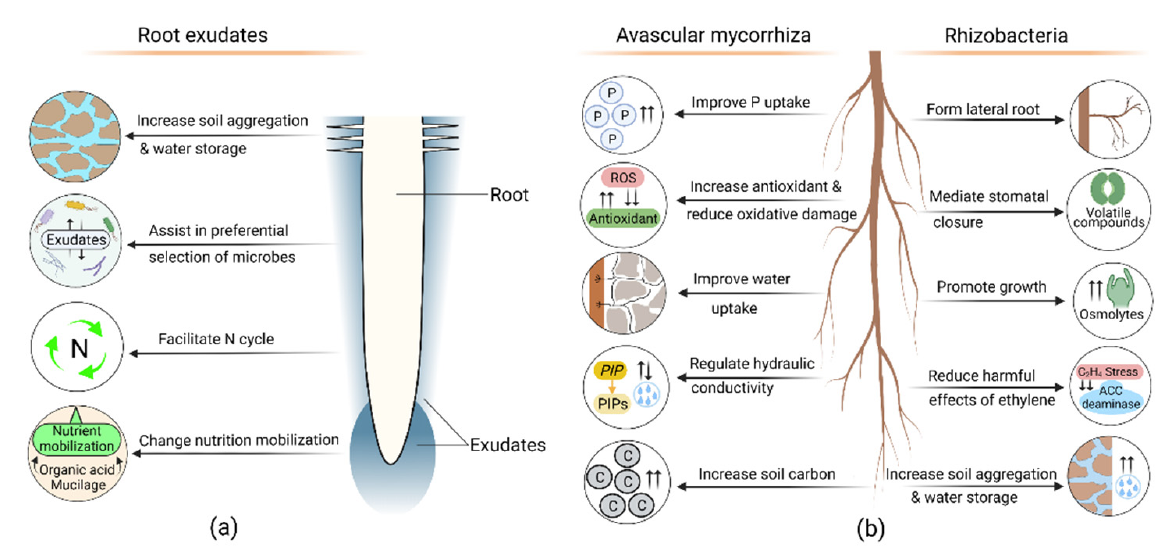
Figure 4. Beneficial roles of root exudates, avascular mycorrhiza (AM), and rhizobacteria in plant drought adaptation. ( a ) Exudates effects soil aggregation, water holding capacity, and nutrient mo- bilization. The plant preferentially selects microbes through exudation, which assists in drought adaptation. Exudates also influence the soil nitrogen (N) cycle. ( b ) AM increases phosphorus (P) and water uptake, affecting root hydraulic conductivity and reducing drought stress by producing antioxidants. AM also increases soil carbon. Rhizobacteria release exopolysaccharides, volatile com- pounds, osmolytes, ACC-deaminase, and phytohormones. These compounds increase soil aggrega- tion, lateral root formation, and plant growth; mediate stomatal closure, reduce ethylene’s harmful effect, and ultimately increase drought resistance.